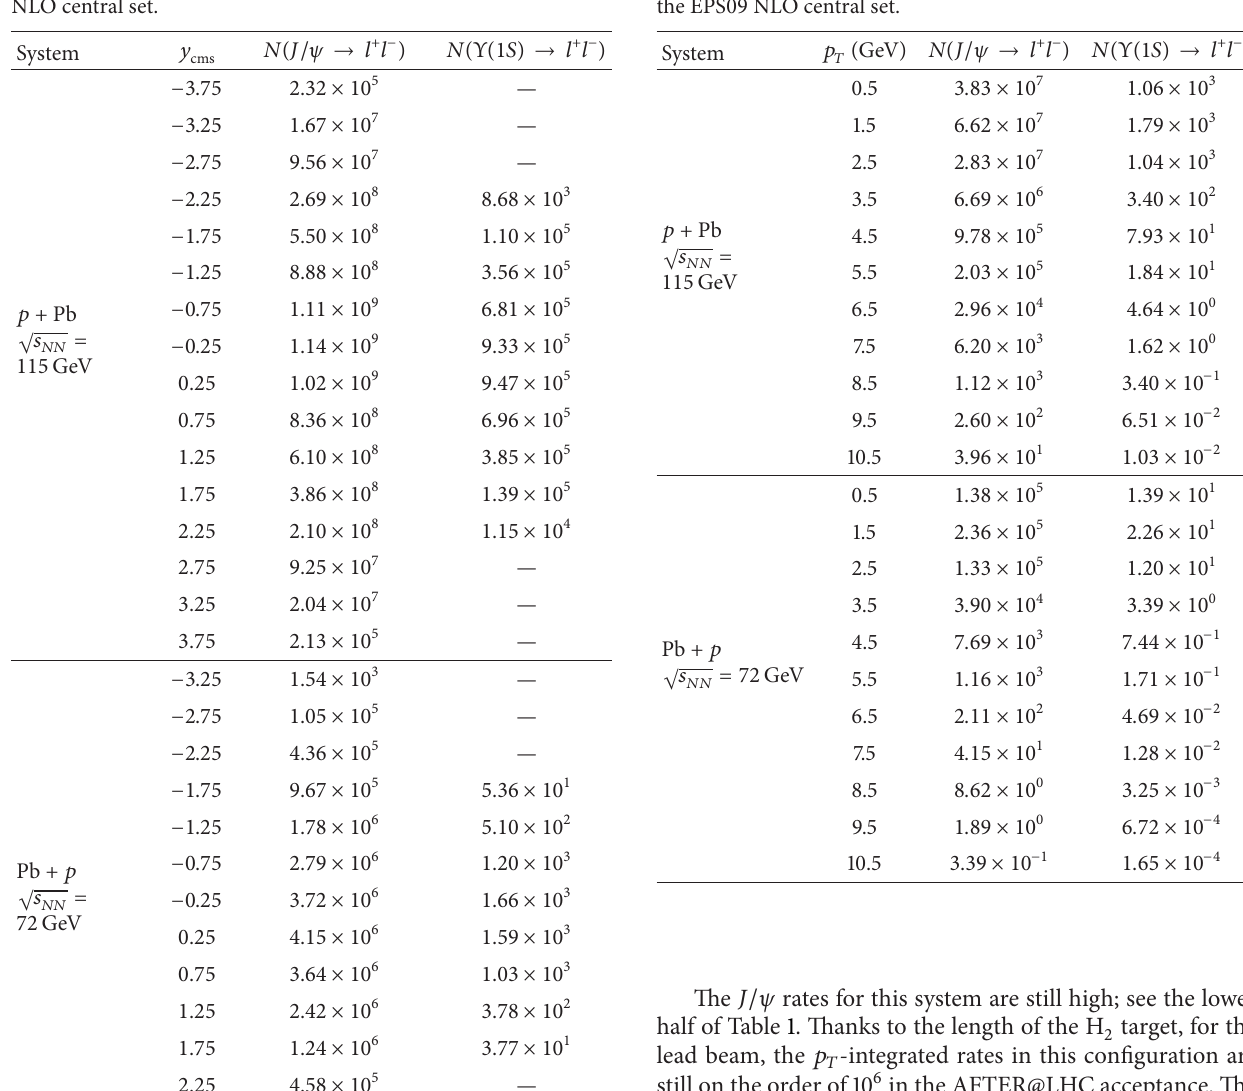
Table 1: The rates per 0.5-unit rapidity for 𝐽/𝜓 and Υ(1𝑆) in the two scenarios discussed in the text. The values are given for the EPS09 NLO central set.